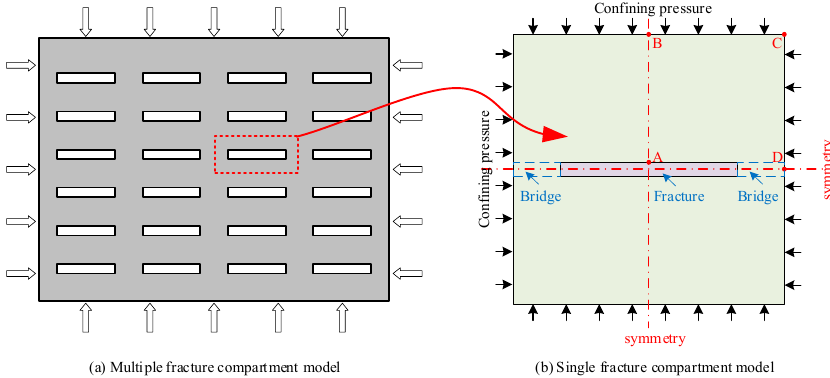
Figure 1. Numerical model under the unconstrained (constant total stress) boundary condition. ( a ) Multiple fracture compartment model; ( b ) single fracture compartment model as a representative element.